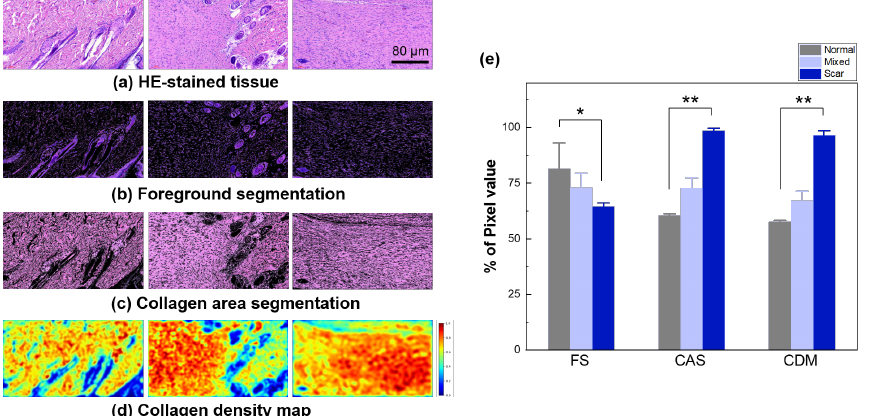
Figure 7. Tissue analysis with color segmentation with K-means clustering: ( a ) original dataset (HE-stained tissue), ( b ) foreground segmentation (FS; HFs, Gs, and N), ( c ) collagen area segmentation (CAS), ( d ) CDM, and ( e ) statistical comparison of FS, CAS, and CDM (input size = 886 × 1614; scale bar = 80 µm; 16X; * p < 0.05 and ** p < 0.005 between normal and